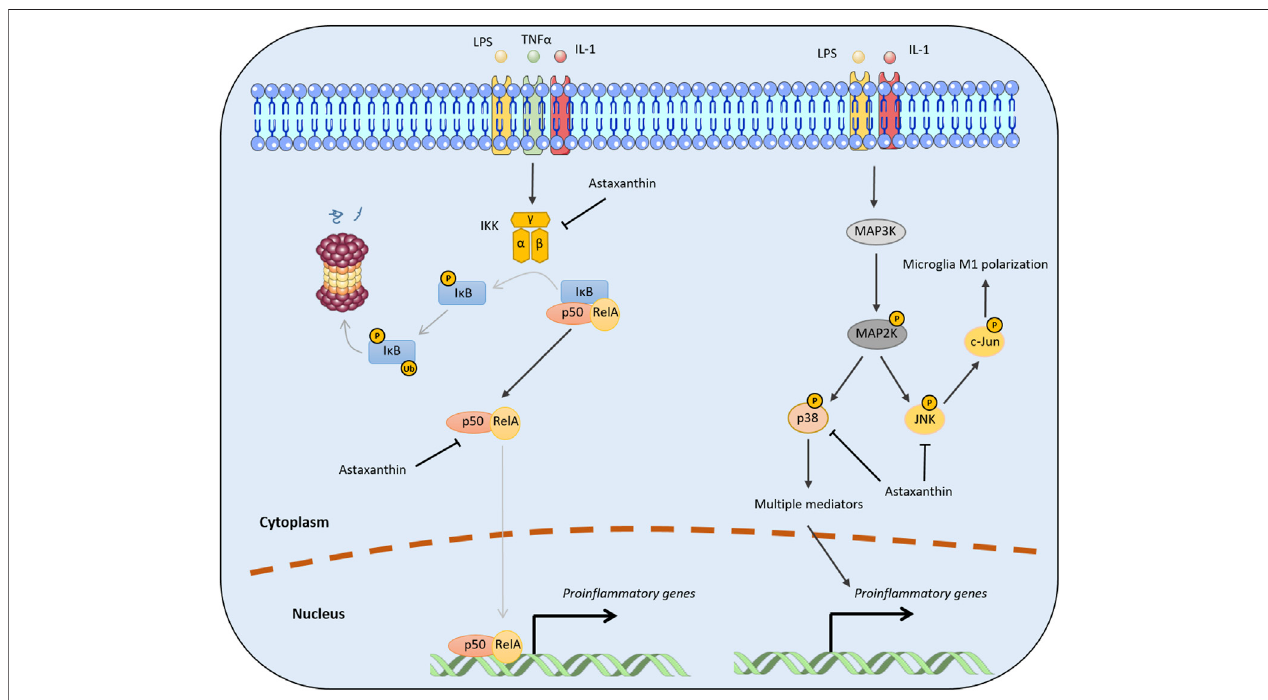
FIGURE 3 | Molecular mechanisms by which astaxanthin inhibits pro-in fl ammatory cytokine production. The black arrows represent positive regulation, while the lines with T-shaped ends represent inhibition. Gray lines indicate the processes of phosphorylation, ubiquitination, or nuclear translocation. P and Ub represent the phosphorylation and ubiquitination of target proteins,